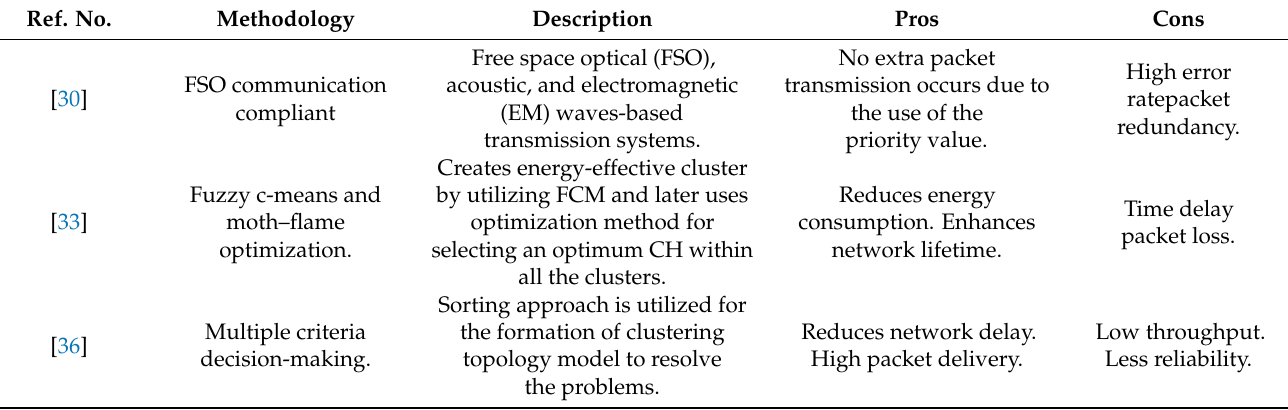
Table 1. The state-of-the-art clustering with multihop routing protocol for underwater wireless sensor